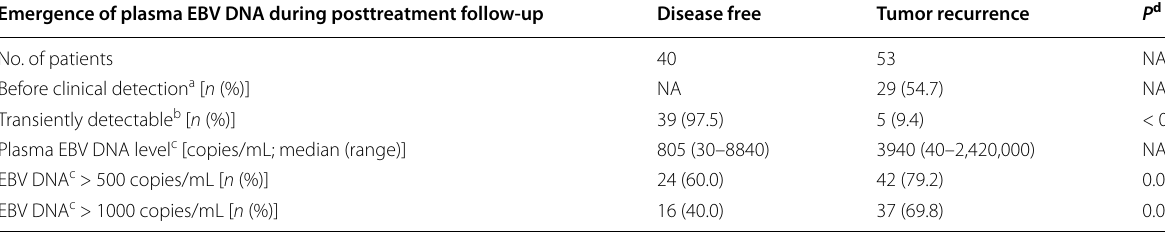
Table 3 Plasma EBV DNA levels in the 93 patients with detectable EBV DNA during posttreatment follow-up